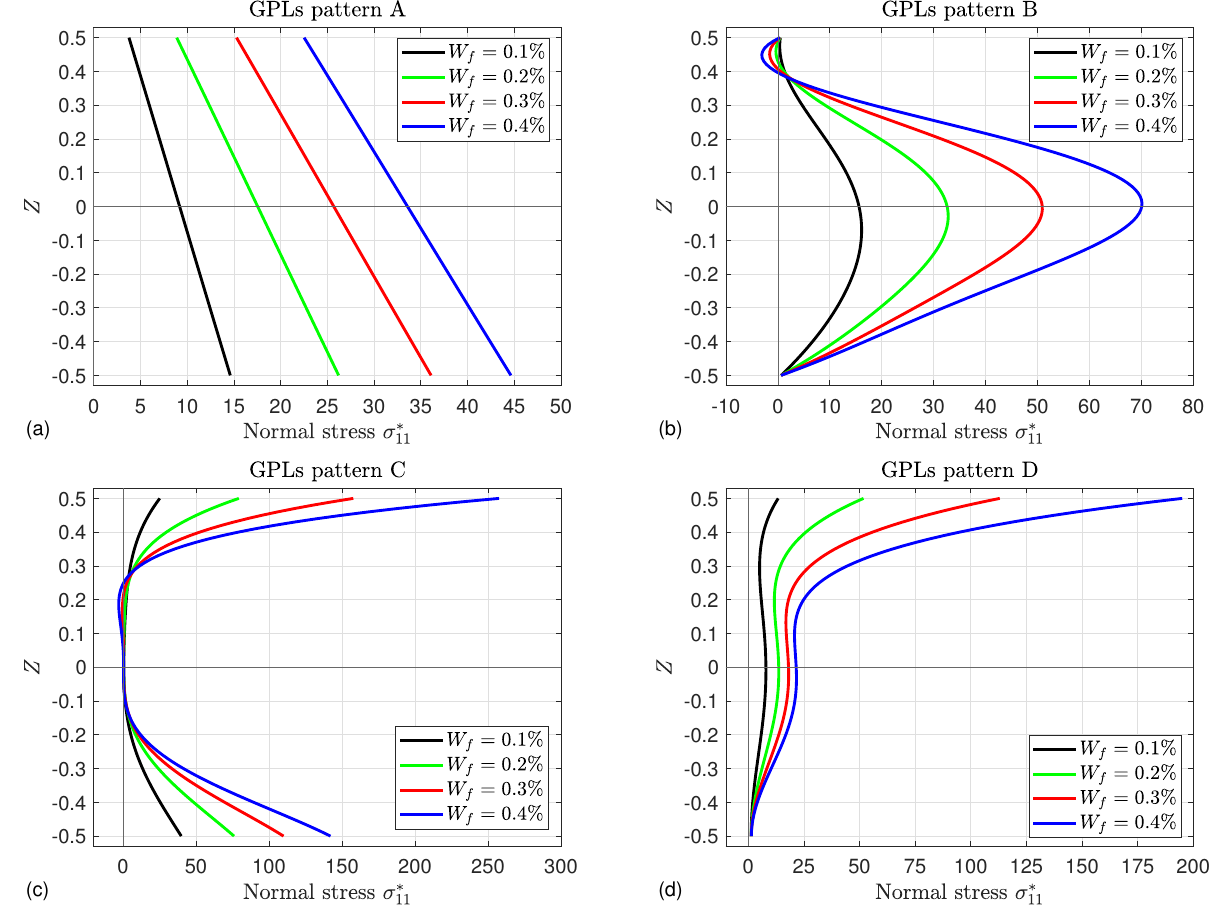
Figure 9. Influence of the GPL weight fraction W f on the normal stress σ ∗ ite piezoelectric square plates for different graphene distribution patterns: ( a ) Pattern A, ( b ) Pattern B, ( c ) Pattern C and ( d ) Pattern